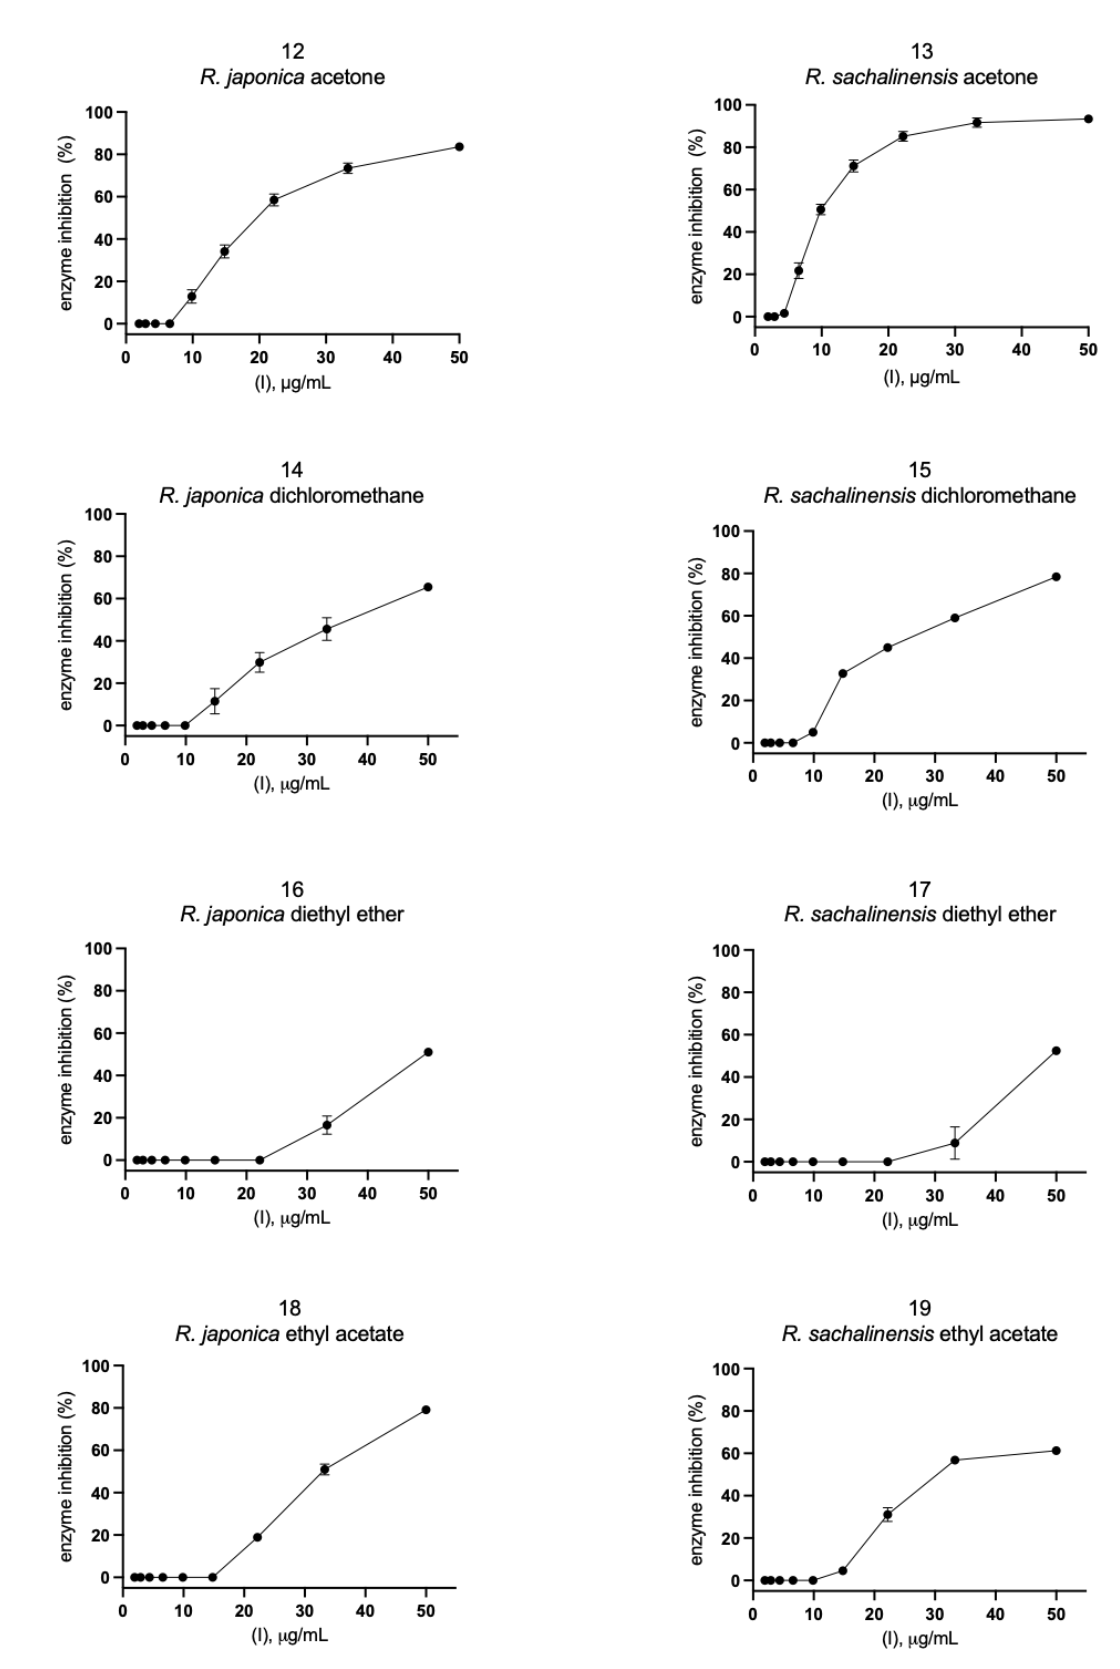
Figure 6. SARS-CoV-2 Mpro activity in serial dilution of extracts and fractions. The results were presented as SARS-CoV-2 Mpro inhibition (%).